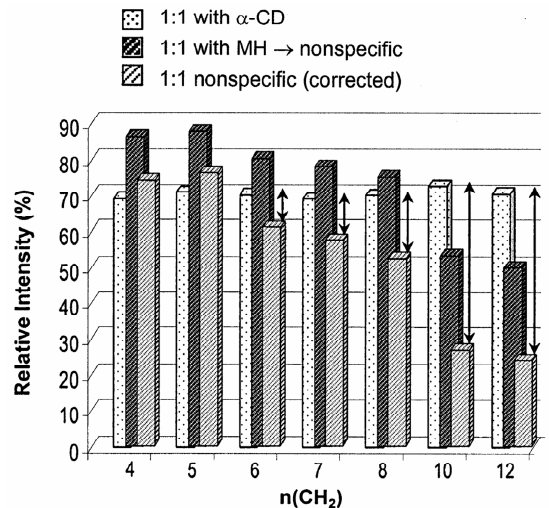
Figure 7. Relative intensities of the α -CD/diacid complexes (white bar with dots), the maltohexaose/diacid complexes (blank bar with dark hatches), and the maltohexaose/diacid complexes after the correction using the response factor (grey bar with light hatches). The arrows correspond to the contribution of inclusion complexes, assuming the nonspecific adducts in both complexes contribute equally. Reprinted from Reference [155], Copyright (2002), with permission from Elsevier.